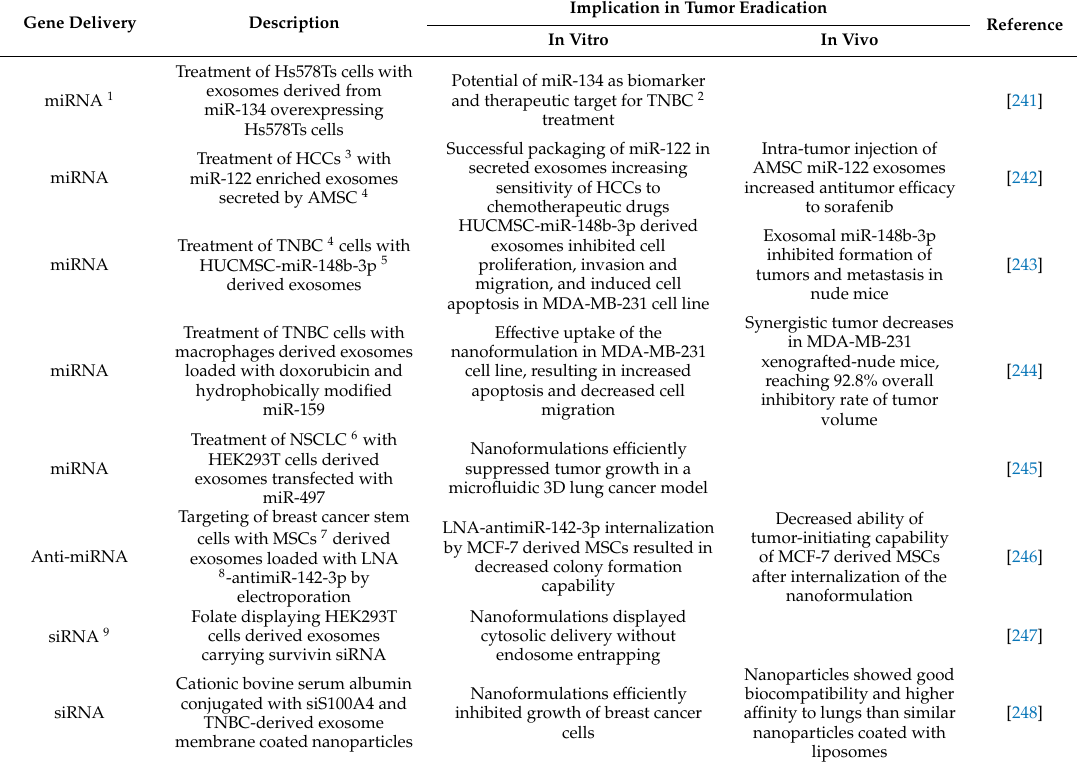
Table 5. Gene therapy strategies using exosomes as gene delivery